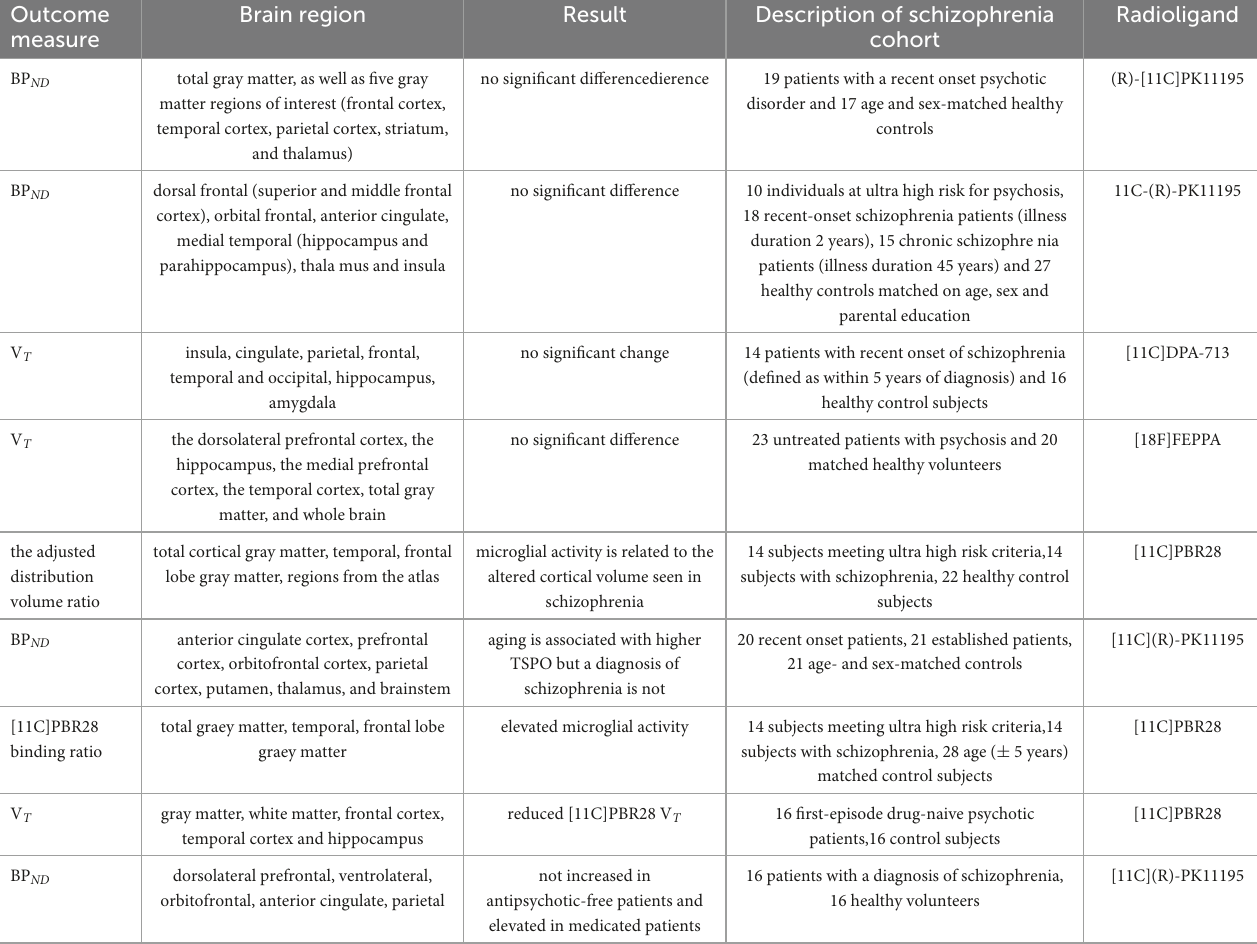
TABLE 1 Results of PET study of different brain regions and microglial marker radioligands in patients with schizophrenia. Outcome